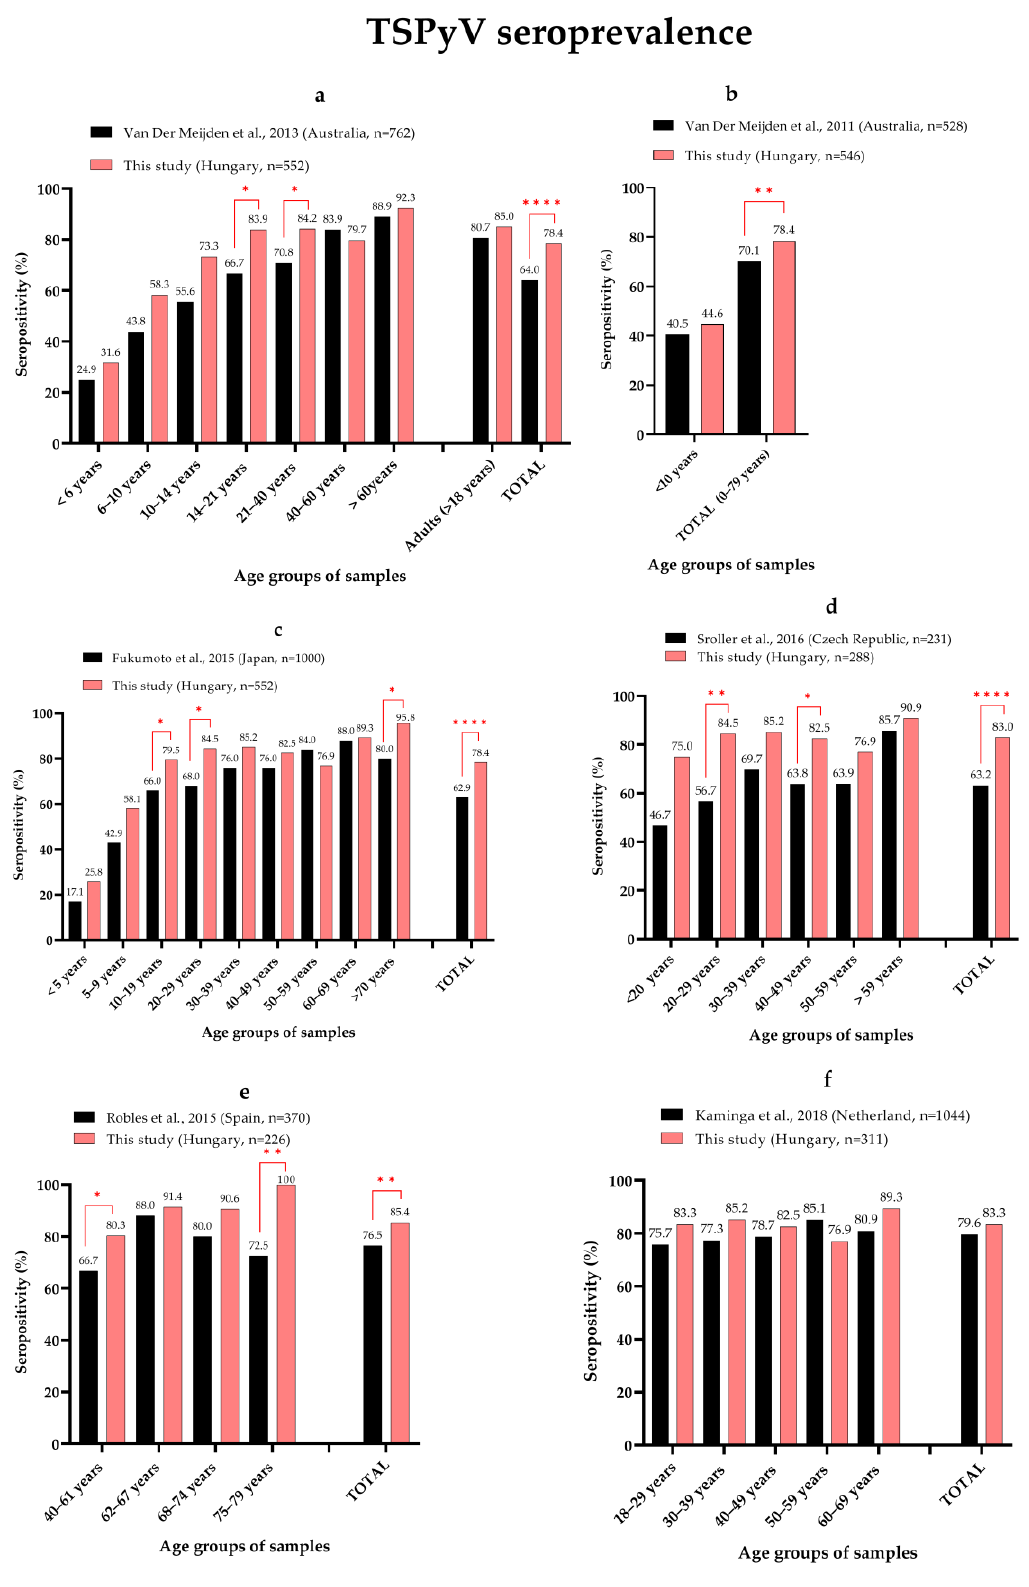
Figure 7. Pairwise comparison of age-specific TSPyV seroprevalence. Each panel represents a comparison between our results and one published study which are the followings: ( a ) [35], ( b ) [53], ( c ) [54], ( d ) [36], ( e ) [40] and ( f ) [38]. Significant differences between age groups are indicated by red lines and asterisks (Fisher’s exact test, * p ≤ 0.05, ** p ≤ 0.01, **** p ≤